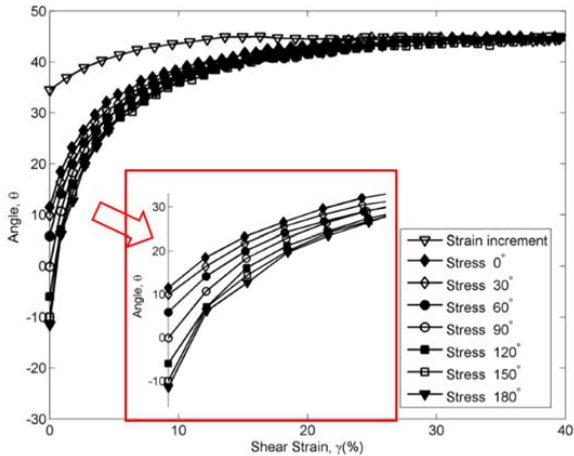
Figure 15. Rotation of principal axes of stresses and strain increment in different stress paths at CSR=0.1 [60].